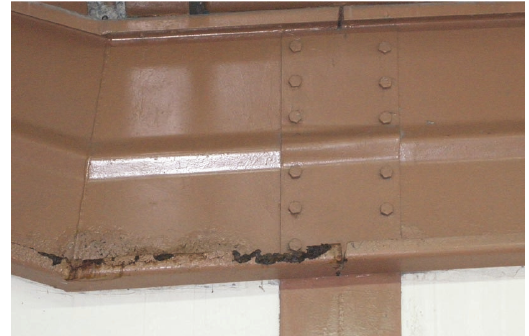
Fig. 1. Corrosion attack on cold-formed beam in an urban at- mosphere, sheltered exposure, Naples